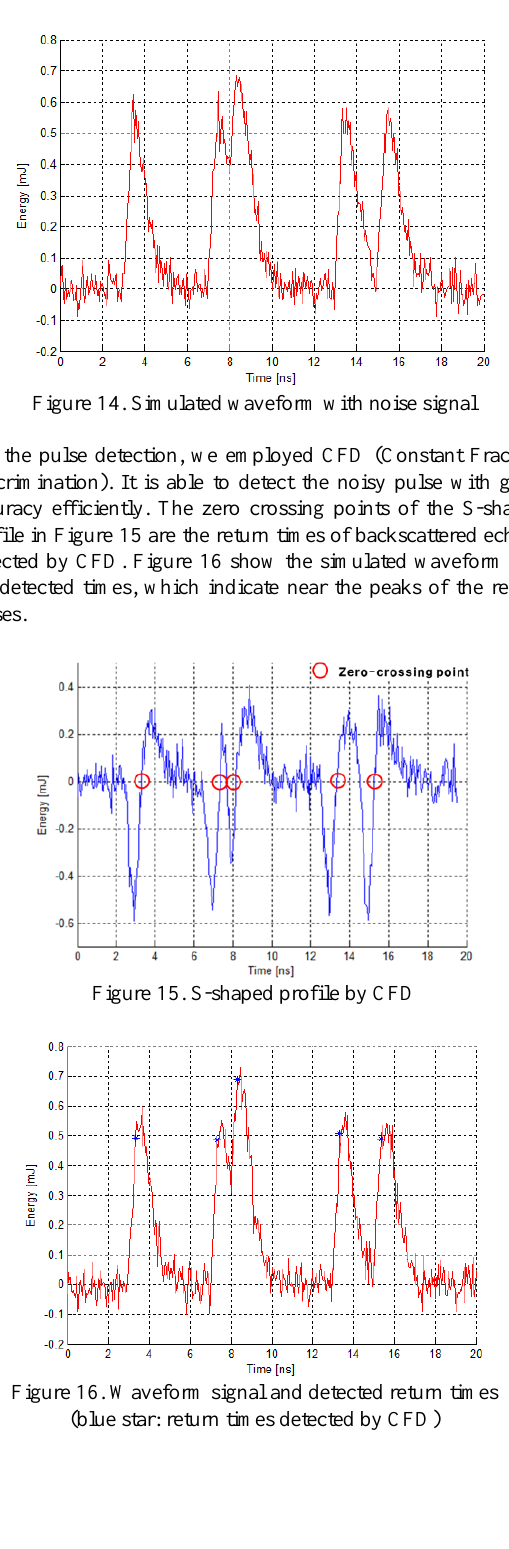
Figure 13. Pseudo signal noise generated by NEP